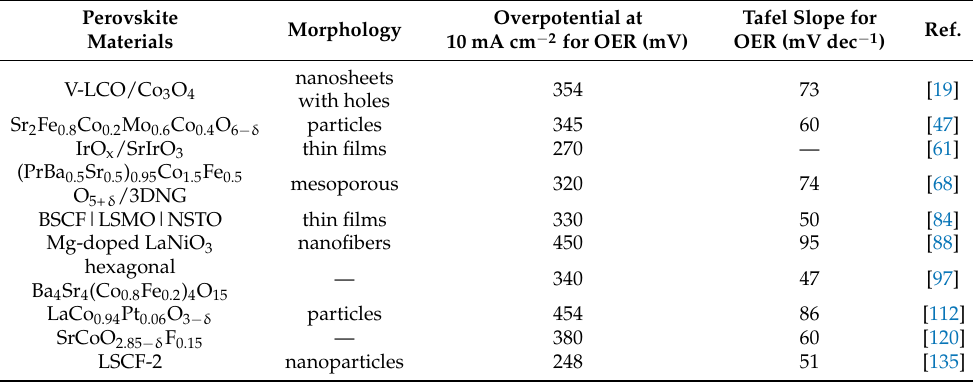
Table 1. Summary of the properties and electrocatalytic activities of different perovskite materials reported in the